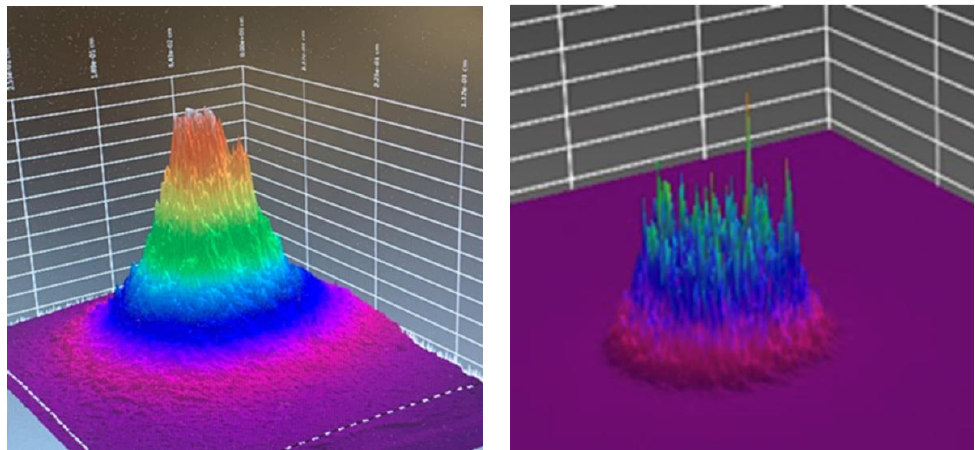
Figure 6. Gaussian beam energy profile ( left ) compared to an optically rectified flat top beam ( right ). Images are intended to display solely differences in optical spatial profile only (different optical sources and parameters).